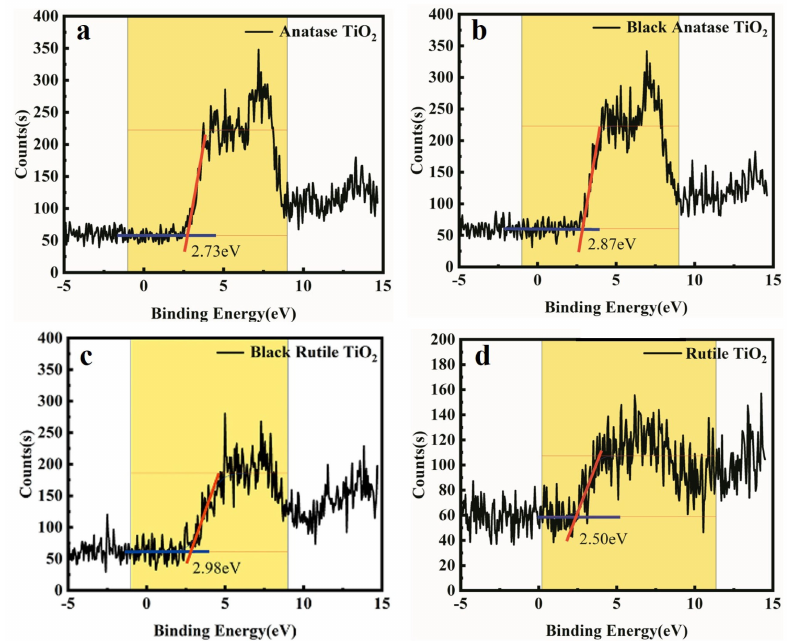
Figure 4. UPS spectra of anatase TiO 2 ( a ) and black anatase TiO 2 ( b ); UPS spectra of rutile TiO 2 ( c ) and black rutile TiO 2 ( d ). The blue and red lines are the fits to be tangent to the regression curves.